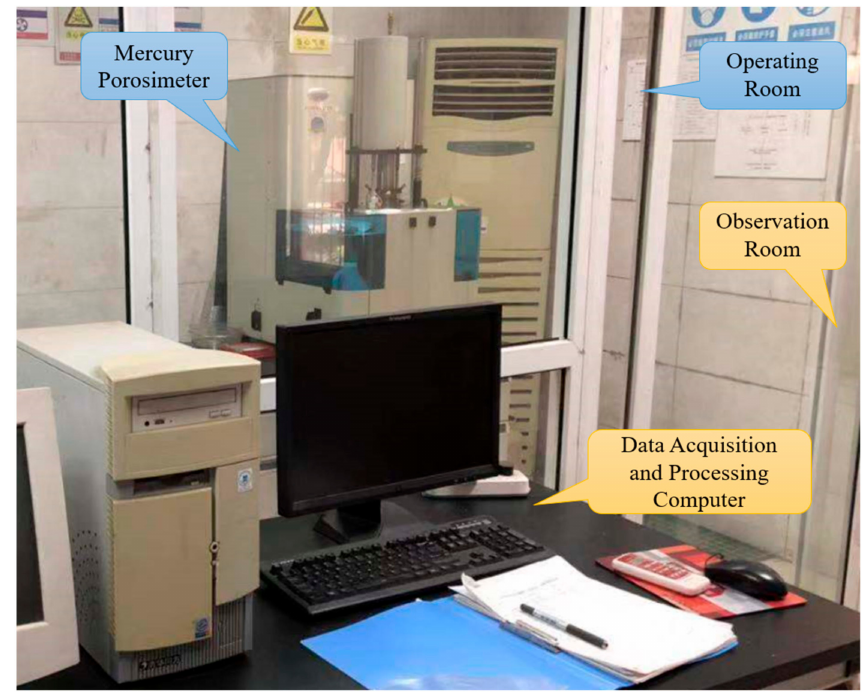
Figure 5. Mercury porosimetry test instrument and operating